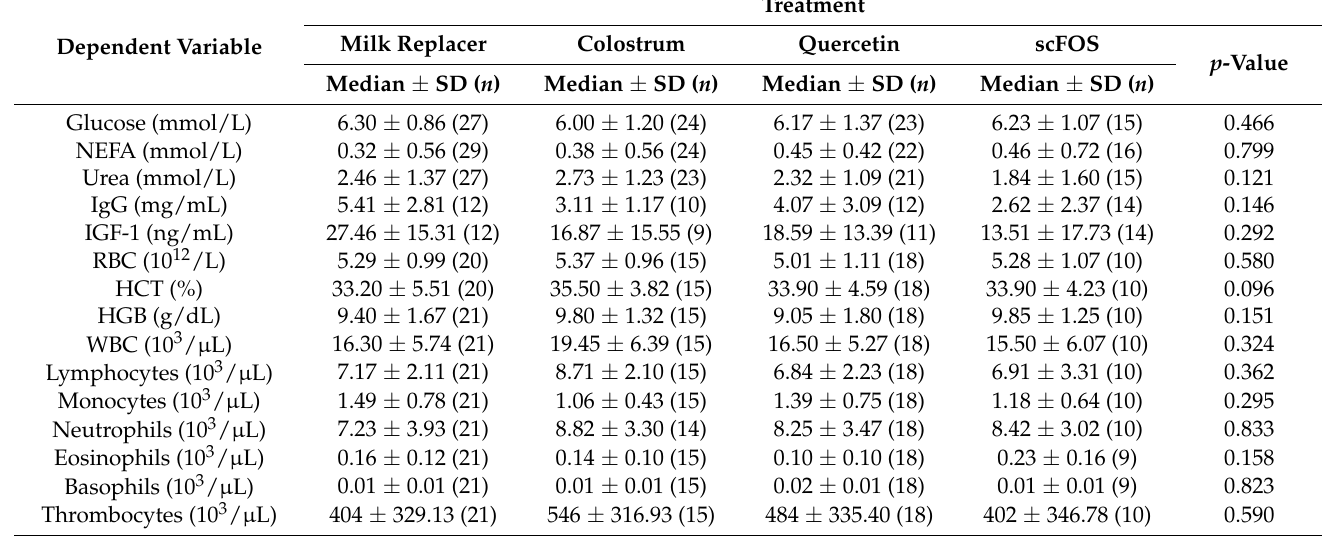
Table 3. Blood values (median ± SD) of glucose, non-esterified fatty acids (NEFA), urea, immunoglob- ulin G (IgG), insulin-like growth factor 1 (IGF-1), red blood cells (RBC), hematocrit (HCT), hemoglob- ulin (HGB), white blood cells (WBCs), lymphocytes, monocytes, neutrophils, eosinophils, basophils and thrombocytes, presented by treatment from selected low birth weight piglets (linear mixed models, p ≤ 0.05).